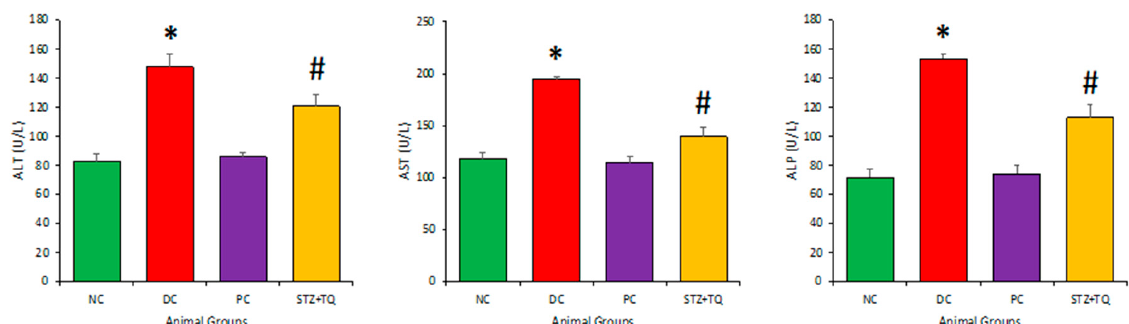
Figure 5. The liver function test profile in different groups of rats after 8 weeks of follow up. The animals were equally divided into each group ( n = 8 per group). Data are means ± standard error of the mean (SEM). Groups: Normal control (NC); disease control (DC) i.e., STZ-treated group; positive control (PC) animal treated with STZ and Glibenclamide; diabetic rats managed with TQ (STZ + TQ). * p < 0.05 (significant difference of between DC vs. NC), # p < 0.05 (significant difference between DC vs. STZ + TQ).